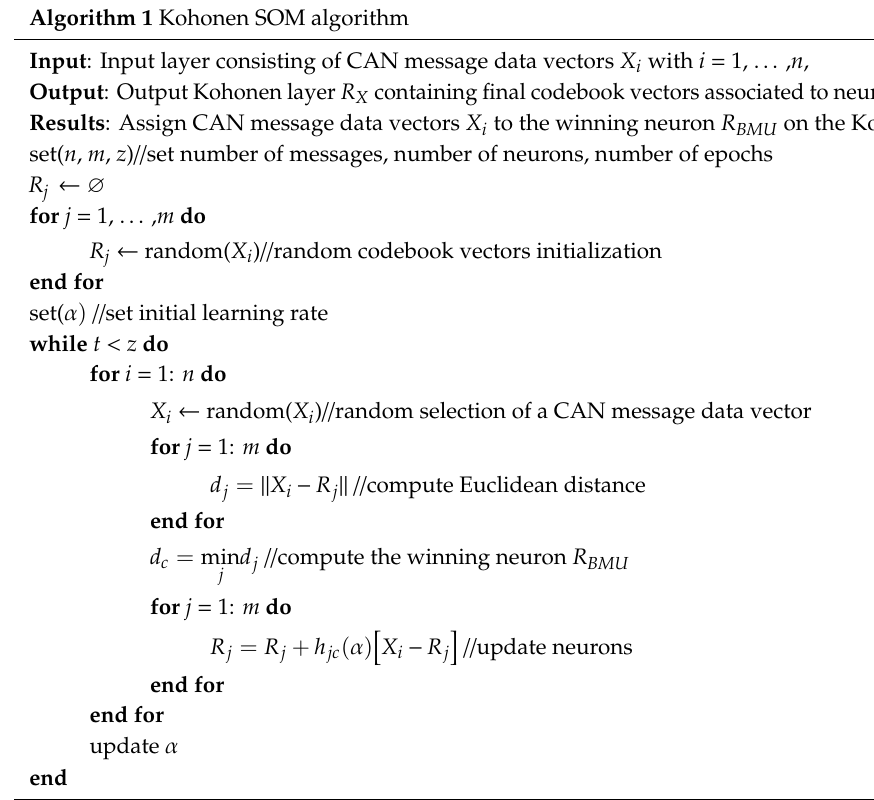
Algorithm 1 Kohonen SOM